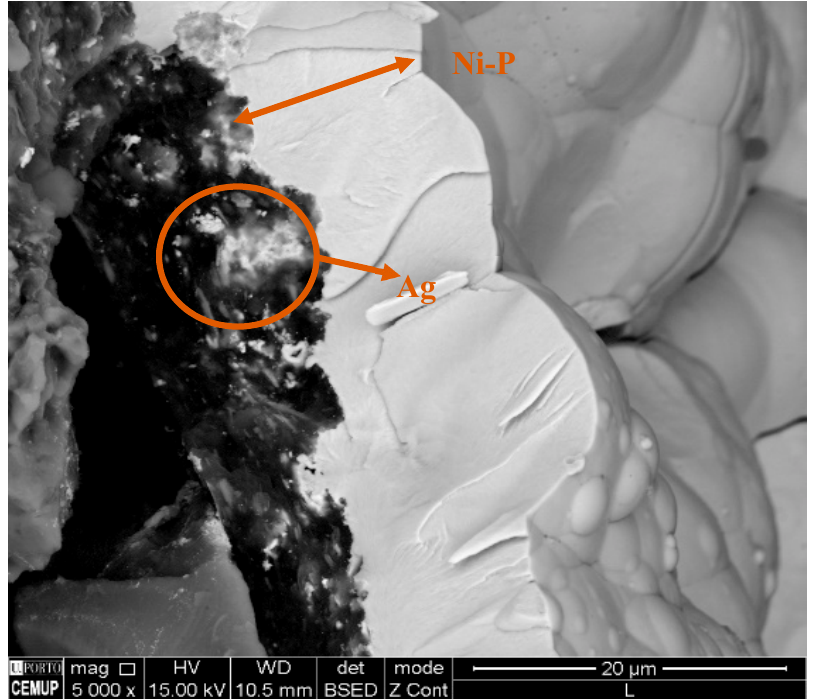
Figure 6. SEM micrographs of PHNBR after electroless Ni-P plating, with an inset at 5000× magnification.